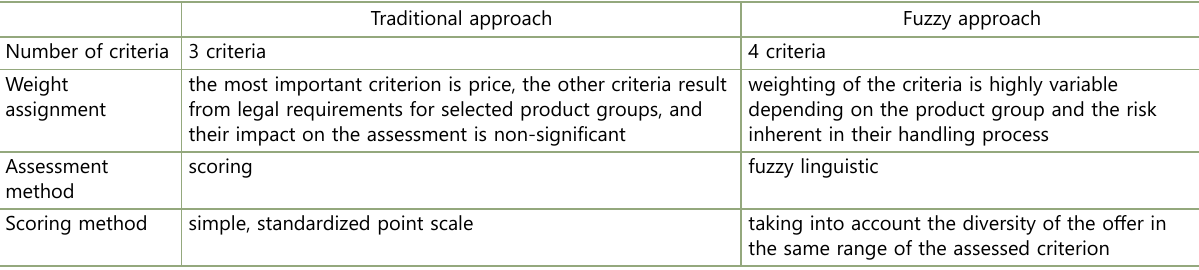
Table 21. Comparison of the traditional approach and the proposed fuzzy TOPSIS approach